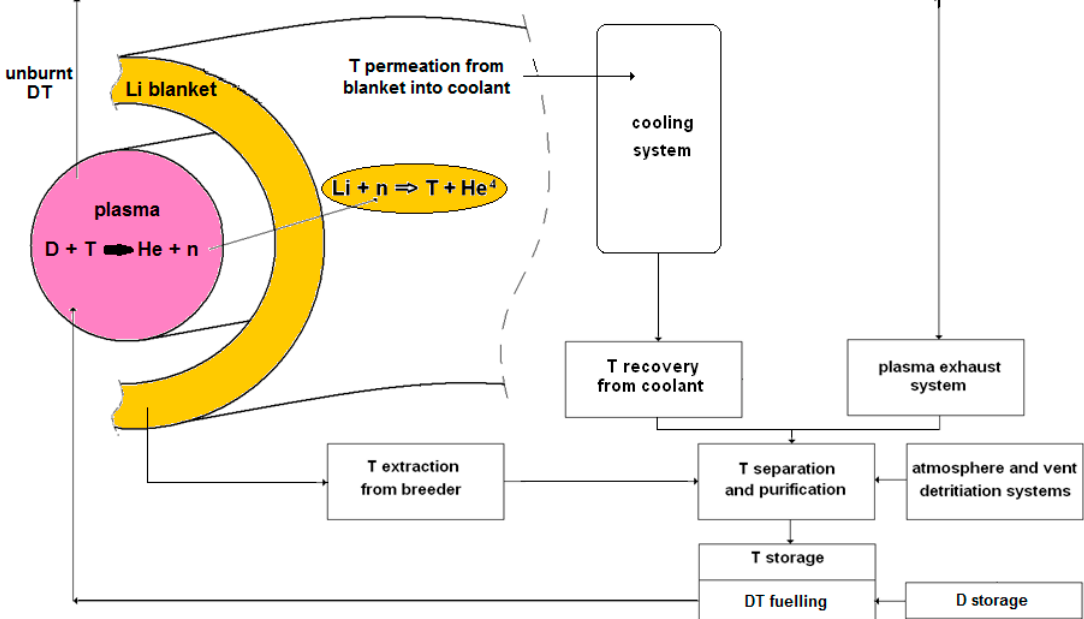
Figure 2. Schematic of the main subsystems of the fusion fuel cycle.